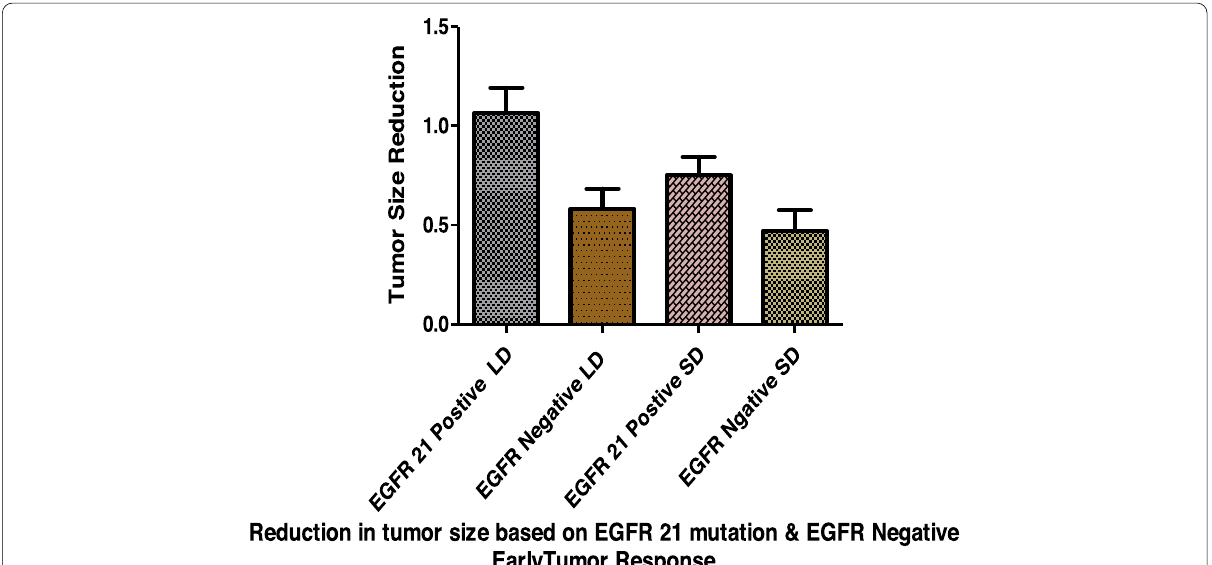
Fig. 2 Reduction in tumor size based on EGFR 21 mutation and EGFR negative early tumor response. LD, long diameter of the tumor axis; SD, short diameter of the tumor